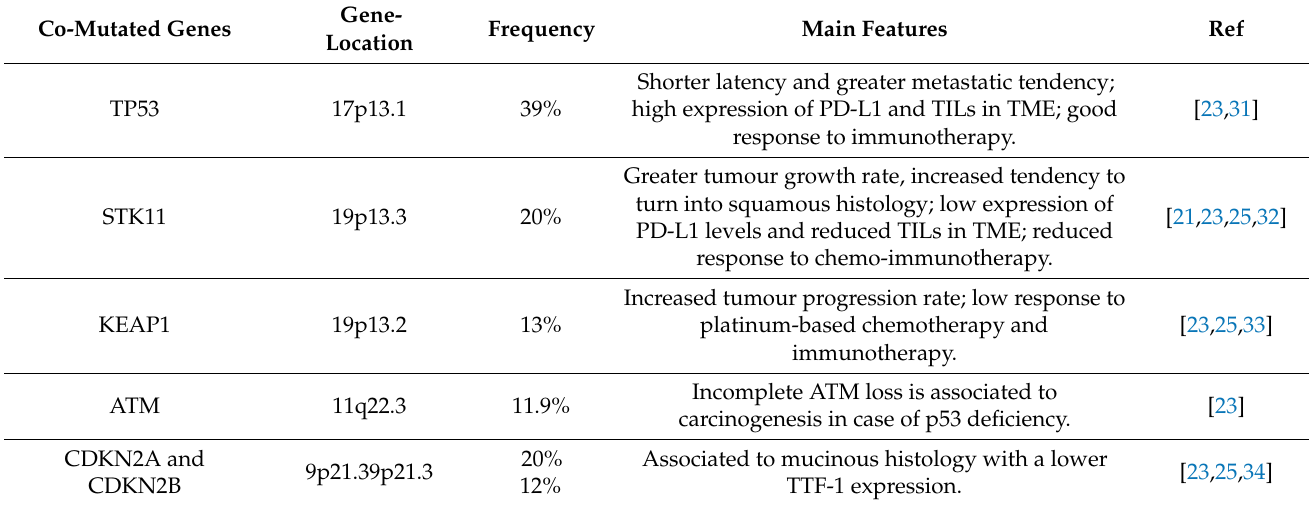
Table 2. Co-mutations in KRAS mutant